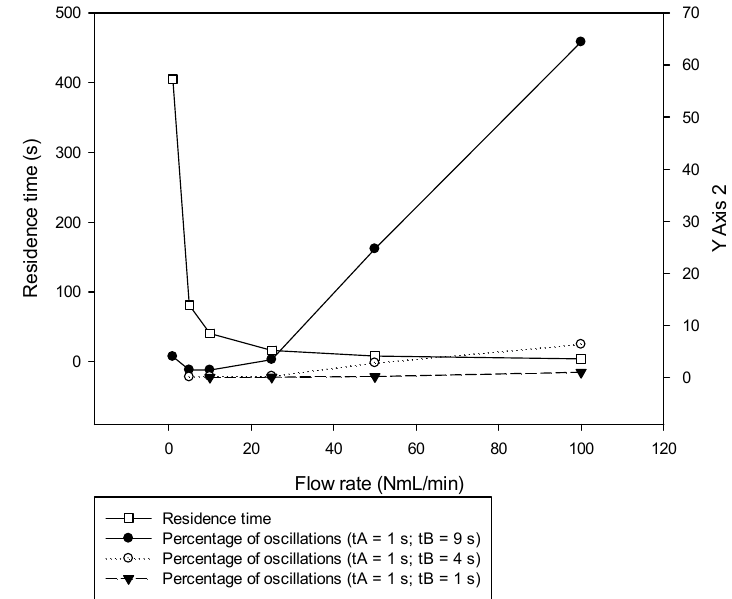
Figure 6. Residence time and percentage of oscillations around the targeted scalar 0.1 for flow rates ranging from 1 to 100 NmL·min − 1 at the exit of the 4th mixing stage. Percentage of oscillations is given for t A = 1 s and t B = 9 s, 4 s and 1 s.